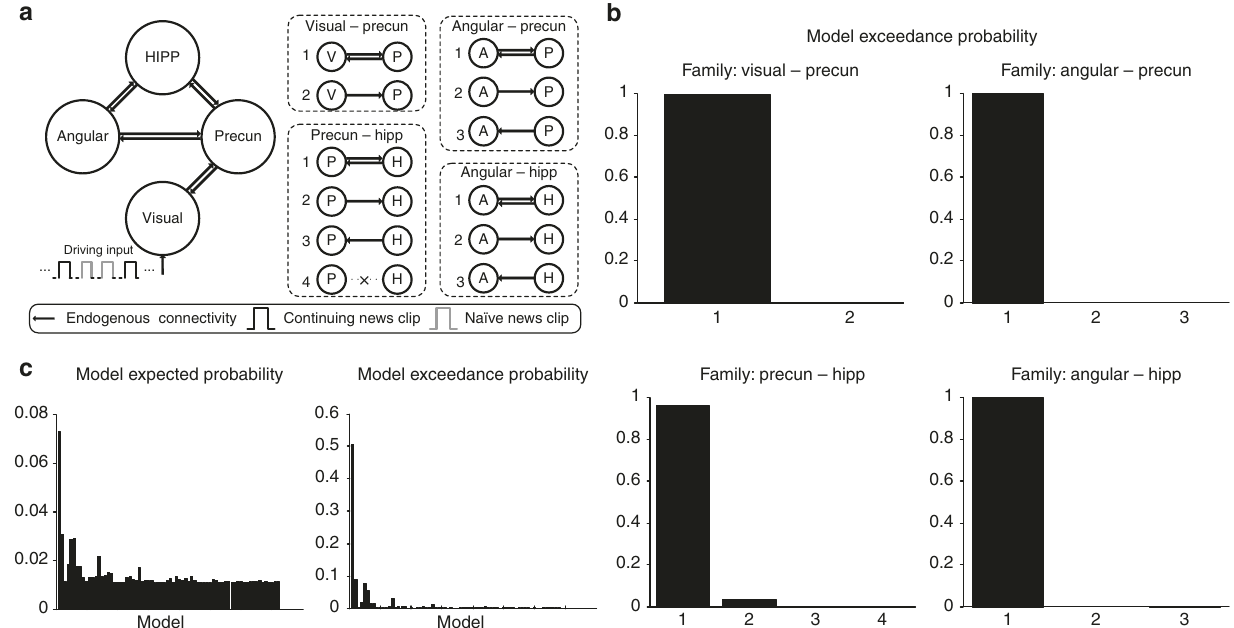
Fig. 2 DCM analyses of endogenous connectivity for second viewing. a Speci fi cation of the model space in terms of four sets of connectivity families, including connections between visual and precuneus, angular gyrus and precuneus, precuneus and hippocampus, angular gyrus and hippocampus, resulting in 72 competing models. For all the models, the visual ROI receives the driving input. b Exceedance probability for the DCM model families in the BMS, including visual – precuneus families, angular gyrus – precuneus families, precuneus – hippocampus families, and angular gyrus – hippocampus families. The label of horizontal axis for each box corresponds to the label in ( a ). Bidirectional families are given fi rst in each box. c Results of the BMS for all the 72 models. HIPP = Hippocampus; Precun = Precuneus; Angular = Angular